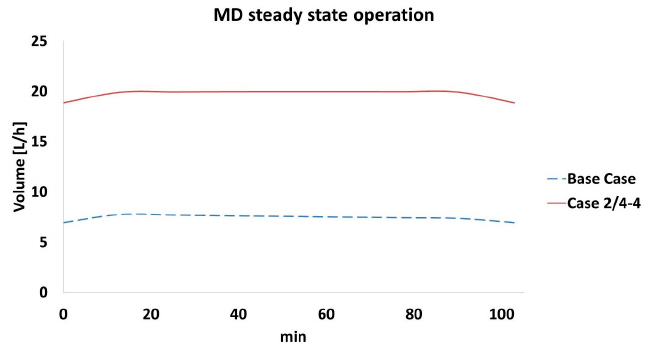
Figure 12. MD distillate at 200 (base case) and 500 L/h (case 2/4-4).